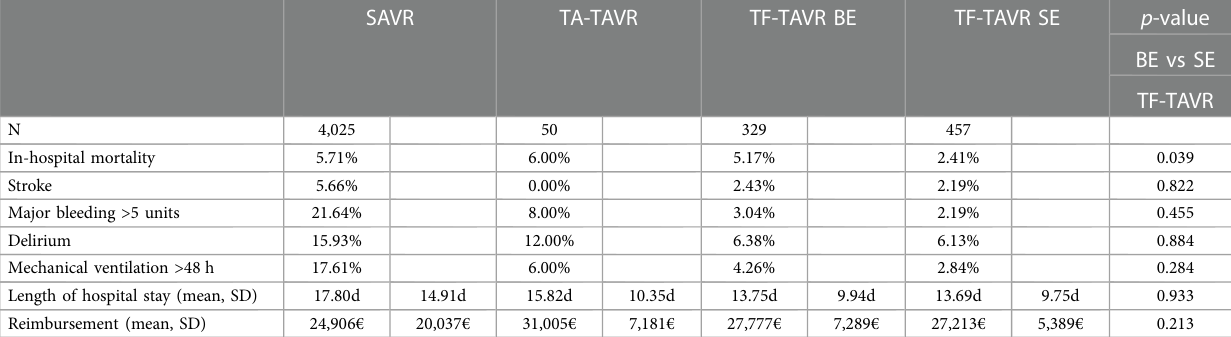
TABLE 2: Unadjusted in-hospital outcomes of patients treated for aortic regurgitation between 2018 and 2020.